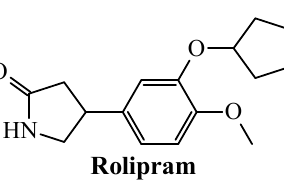
Figure 6. Rolipram: a promising drug computationally predicted and experimentally reported as a dual inhibitor of caspase-1 and TNF-alpha.